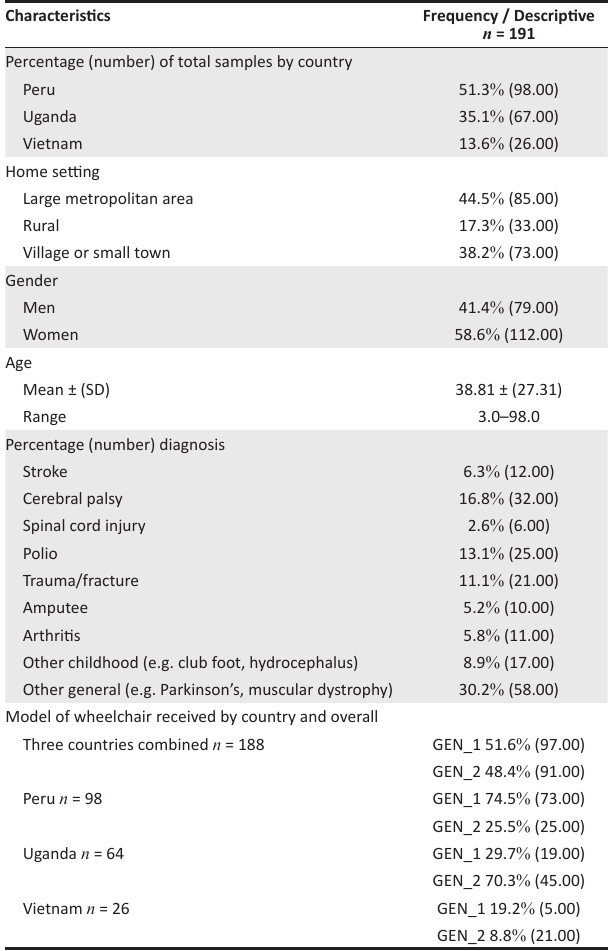
TABLE 3: Demographics of study